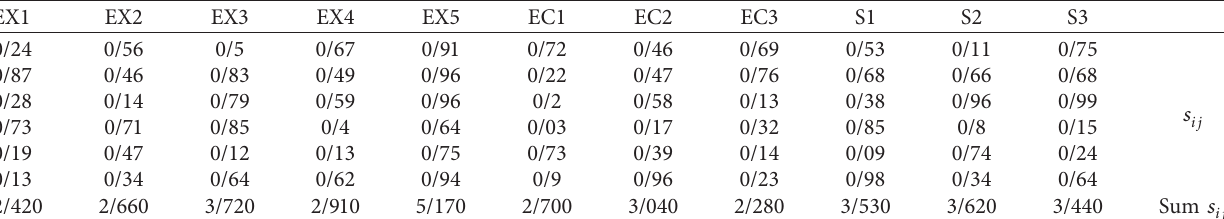
Table 5: S values.